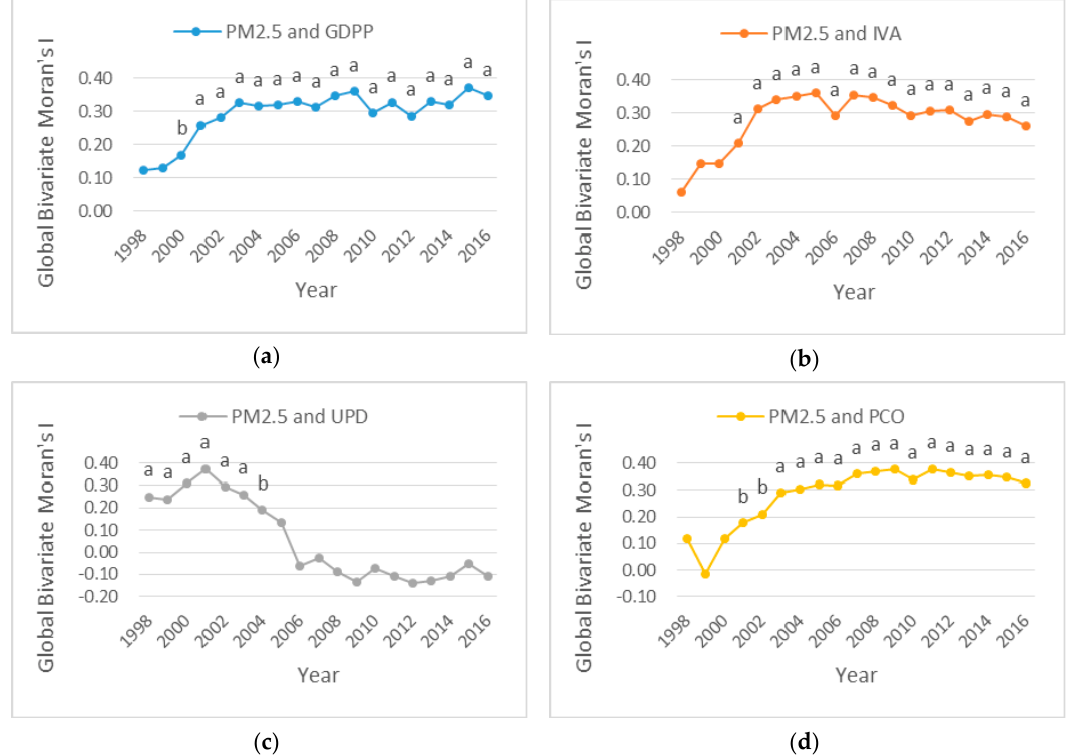
Figure 10. LISA cluster map of PM 2.5 concentration for 31 provinces, 1998-2016.